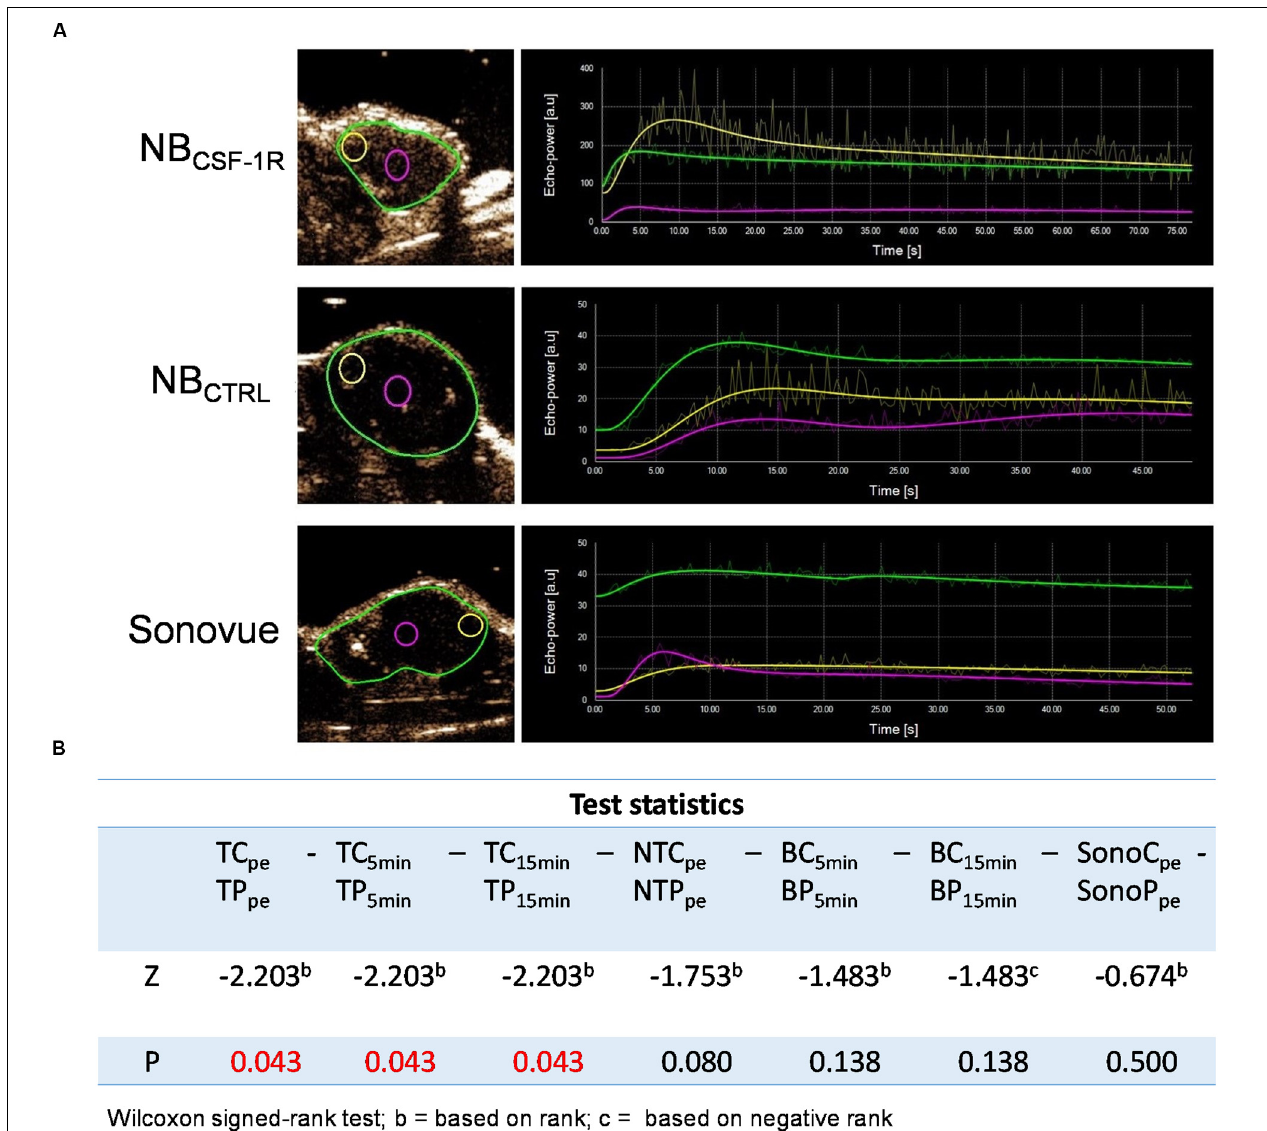
FIGURE 8 | (A) The echo intensity fitting curve of the same area around or in the center of transplant tumor with NB CSF − 1R , NB CTRL , and Sonovue R (cid:13) . The intensity of the peritumoral echo signal of the NB CSF − 1R was significantly higher than that of the central tissue at the peak time, 5 and 15 min ( p = 0.05). Data was shown in panel (B)